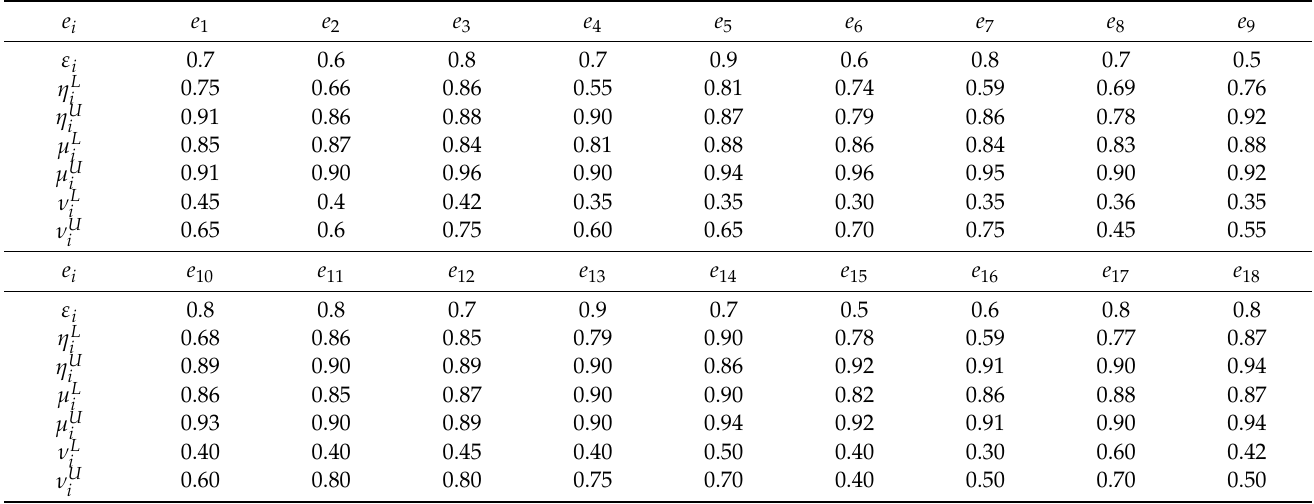
Table 4. Confidence level of experts regarding trust degree, similarity, consensus level, and coopera- tion willingness.